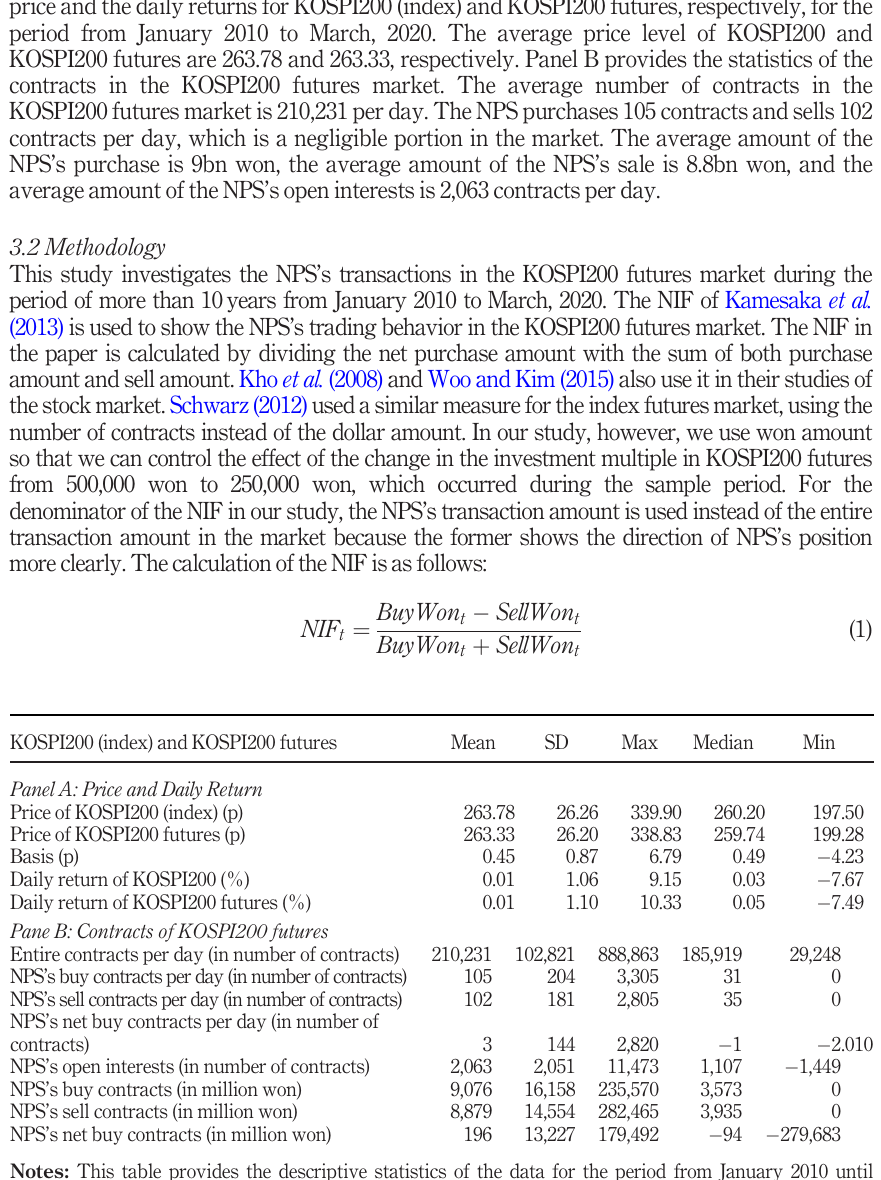
Table 1. Descriptive statistics